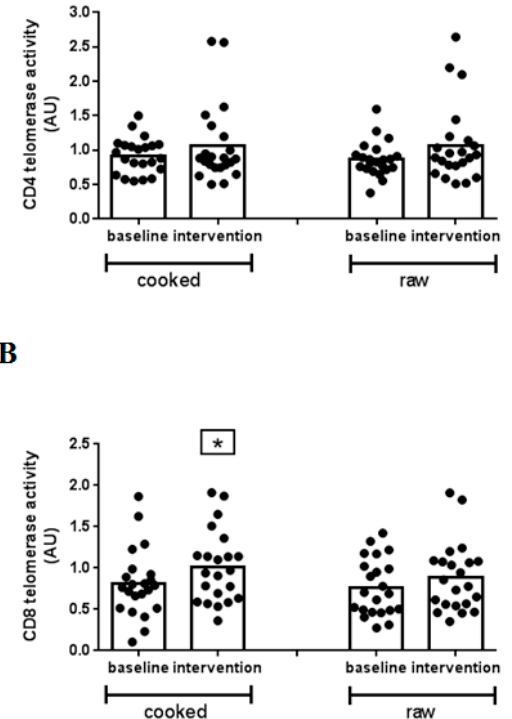
Figure 3. Effect of B. carinata intervention on telomerase activity in CD4+ and CD8+ T cell subsets. Telomerase activity was measured in isolated CD4+ T helper ( A ) and CD8+ cytotoxic T cells ( B ) at baseline and post intervention using the TRAP-ELISA assay. Each sample was measured in duplicate. Each dot represents one volunteer. The bars are mean values from n = 22 volunteers. Asterisks indicate statistically significant differences between baseline and intervention phase ( p < 0.05).